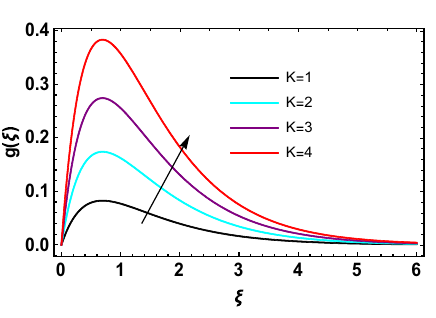
Figure 4. Impact of K upon g (ξ) .